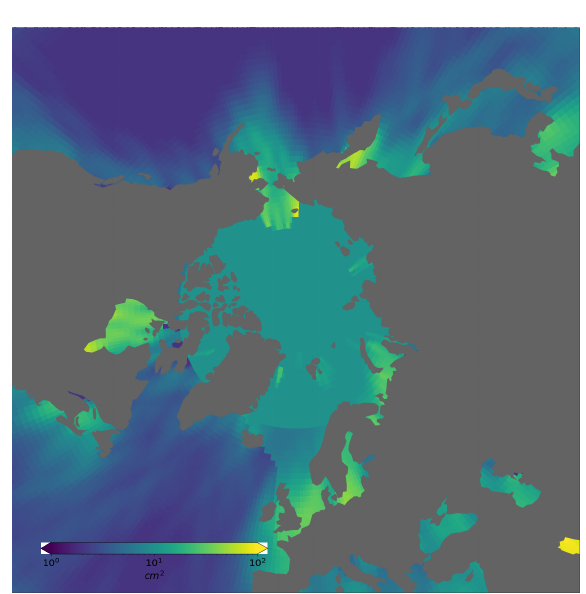
Figure 6. Variance of LWEs used for the Arctic Ocean optimal in-